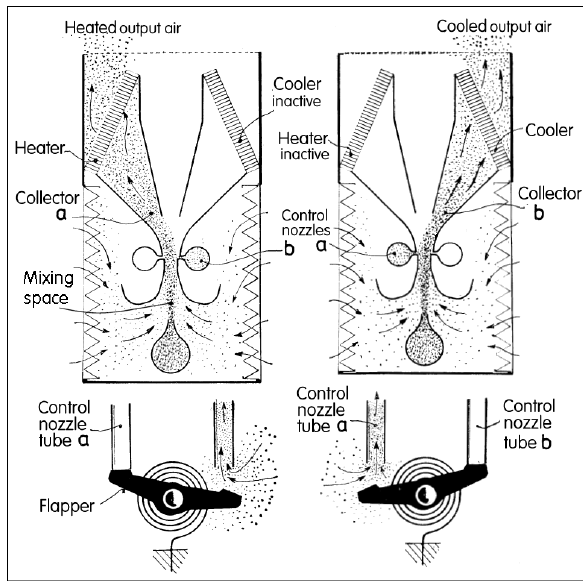
Fig. 9. Two flow regimes in the window-sill terminal unit shown in Fig. 8. The air jet is switched by closing the suction from the atmosphere by the bimetallic flapper thermostat.